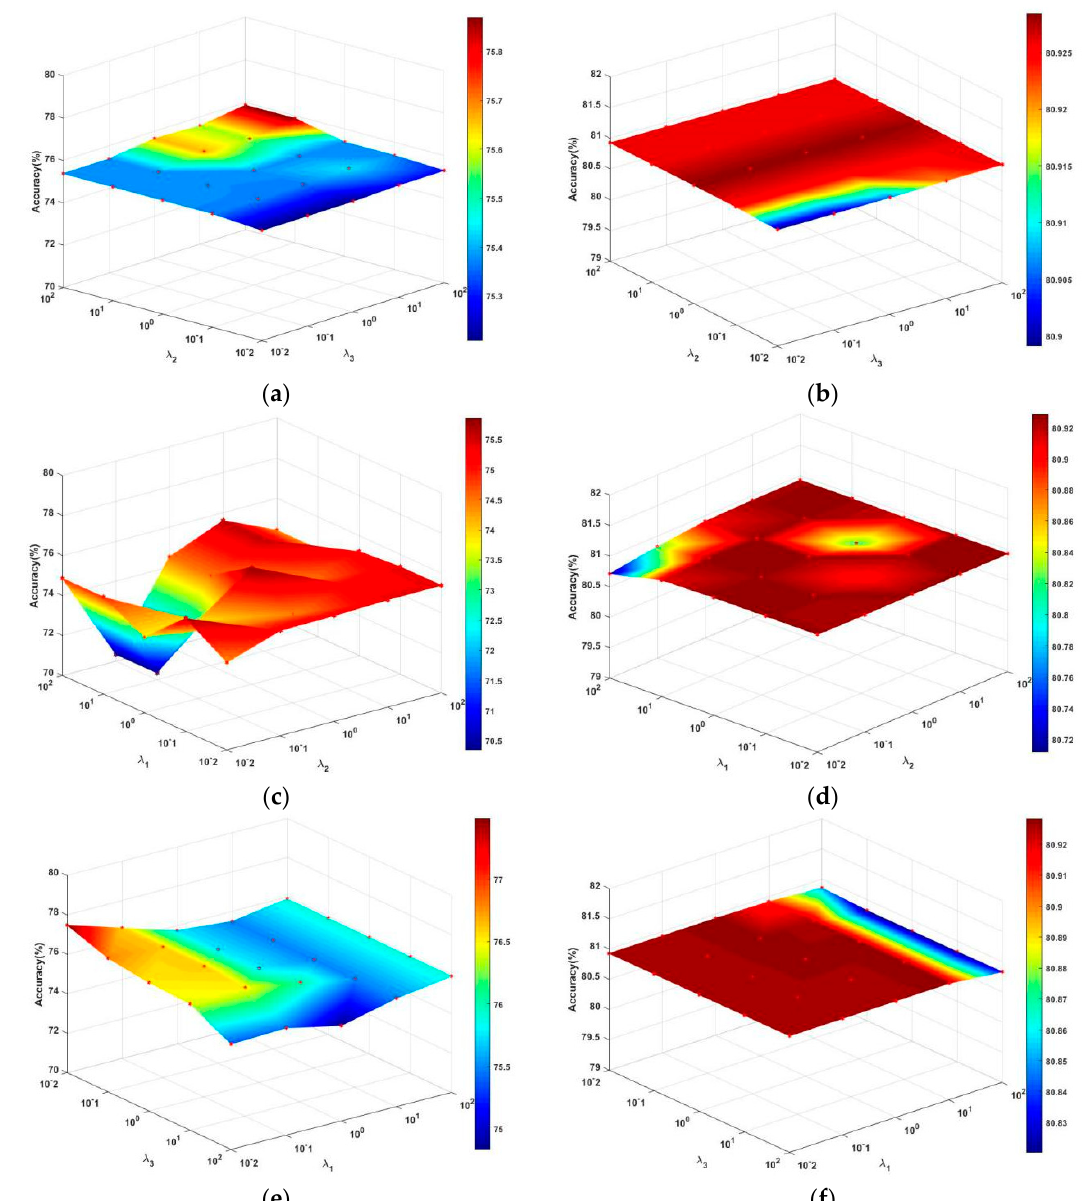
Figure 9. The influence of di ff erent parameters on the classification accuracy. ( a , b ) are the classification accuracy corresponding to di ff erent λ 2 and λ 3 in Scene1 and Scene4 when λ 1 is fixed, respectively. ( c , d ) are the classification accuracy corresponding to di ff erent λ 1 and λ 2 in Scene1 and Scene4 when λ 3 is fixed, respectively. ( e , f ) are the classification accuracy corresponding to di ff erent λ 1 and λ 3 in Scene1 and Scene4 when λ 2 is fixed,